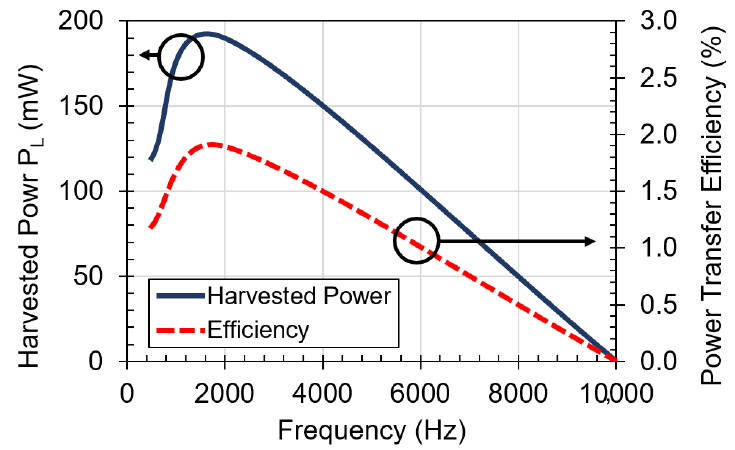
Figure 6. Measured harvested power versus frequency for designed coil with 1 mm-thick aluminum plate in between. Input power is 10 W.